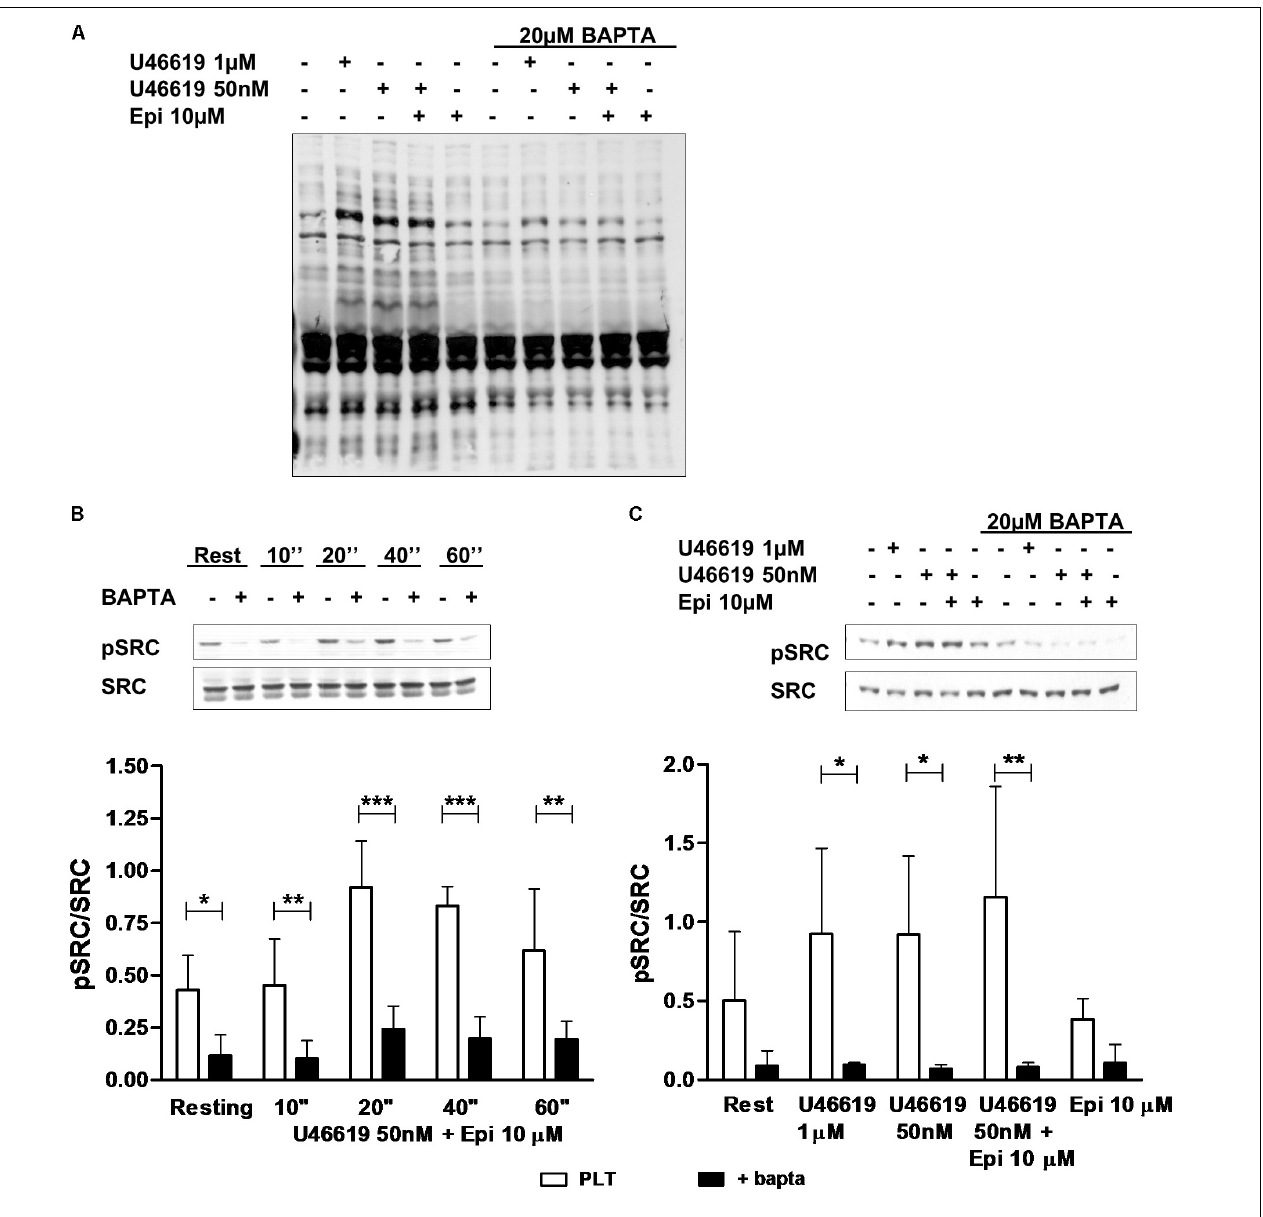
FIGURE 4 | Western Blotting analysis of tyrosine (A) and Src (B,C) phosphorylation. Washed platelets were isolated in non-aggregating condition (eptifibatide 10 µ g mL − 1 , ASA 100 µ M, apyrase VII 10 U mL − 1 ) and stimulated with agonists. The reaction was stopped by adding sample buffer 4 × at 100 ◦ C. (B) Typical pattern of Src phosphorylation after stimulation of 10, 20, 40, and 60 s with U46619 50 nM + epi 10 µ M in condition of intracellular calcium-presence or absence. Graphic is representative of four experiment. (C) Typical pattern of Src phosphorylation after stimulation of 40 s with U46619 1 µ M, U46619 50 nM, U46619 50 nM + epi 10 µ M, and epi 10 µ M in presence or absence of BAPTA 20 µ M. Graphic shows five experiments. Repeated-measures Two-Way ANOVA was applied to compare the effects of platelets agonists on Src phosphorylation at different time points in the presence of different agonists (B,C) . Mean ± SE, ∗ P < 0.05, ∗∗ P < 0.01, ∗∗∗ P <